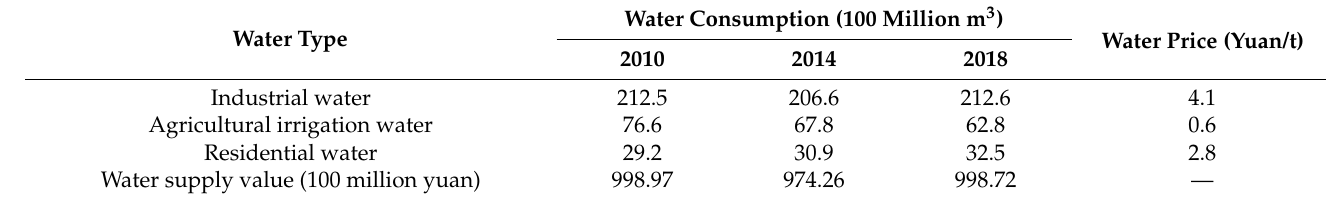
Table 6. Water supply value of Taihu Lake during 2010–2018.